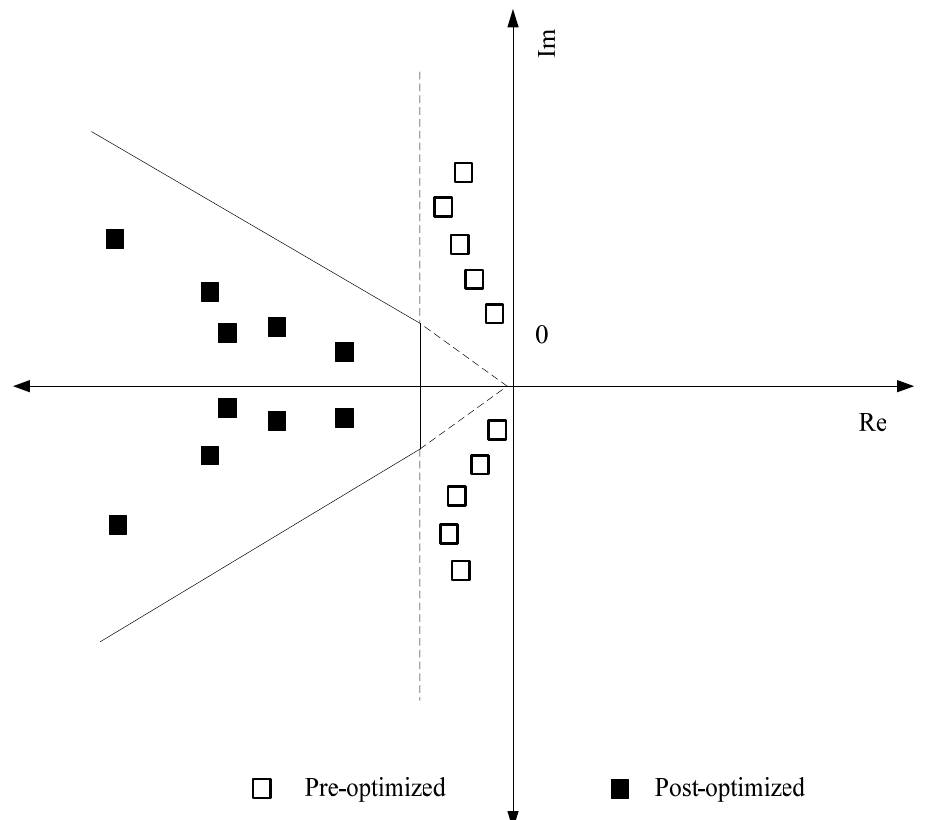
Figure 5. Correlation of eigenvalue sectors (pre- and post-optimised MO).